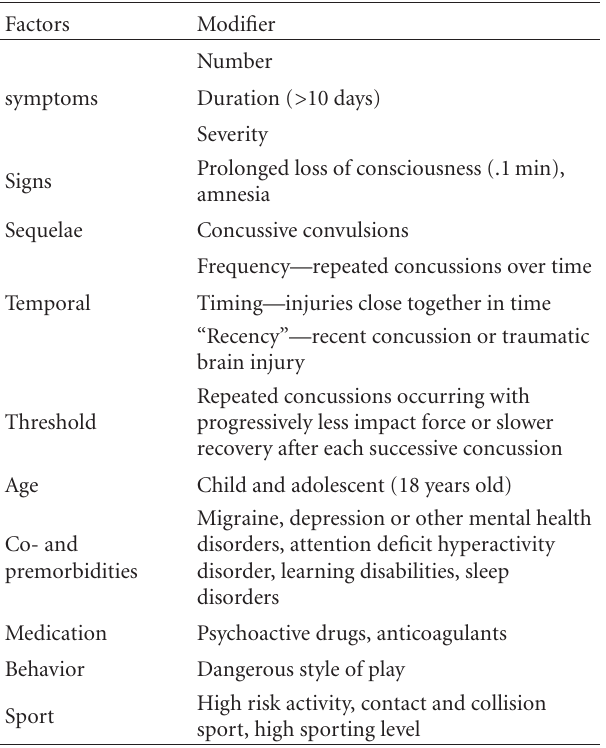
Table 2: Modifying factors in concussion management from con- sensus